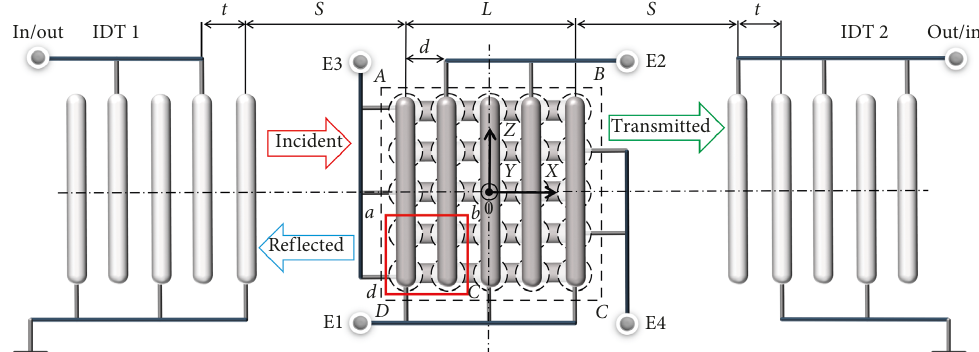
Figure 1: Structure and principle of the SAW device and main axes directions. E1, E2, E3, and E4 are the conductive electrodes.